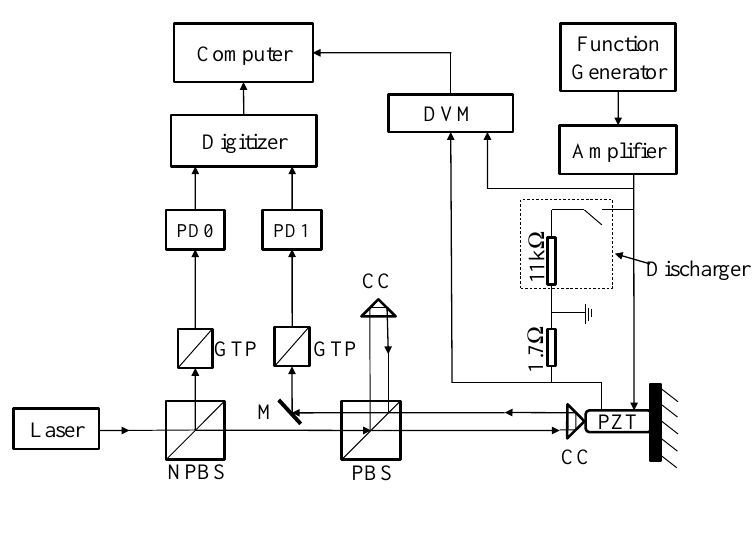
Figure 1. Experimental setup.